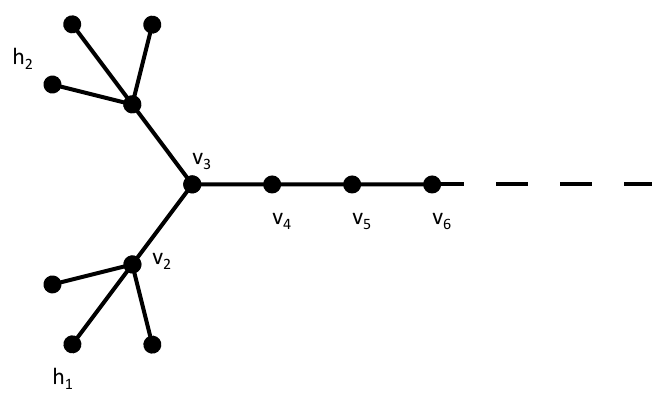
Figure 20: Two peripheral clusters at one end.